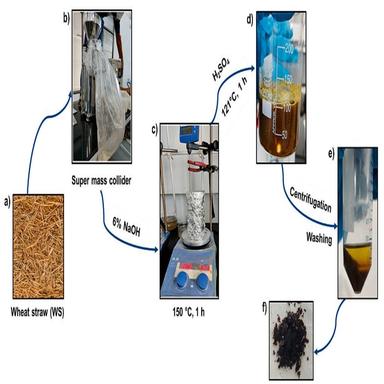
(a-f) Extraction of lignin from wheat straw.